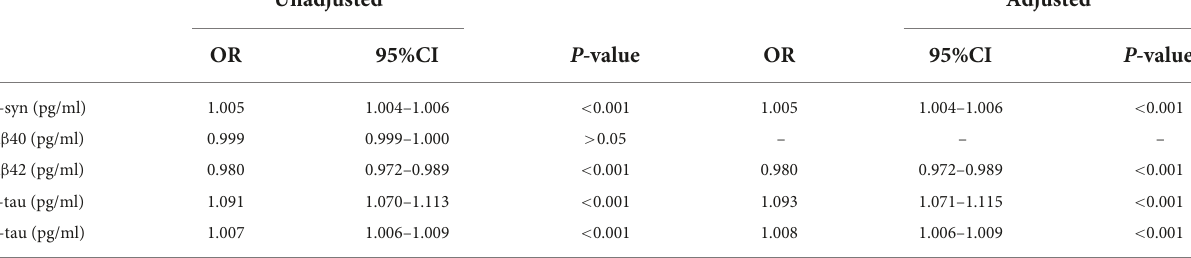
TABLE 2 Logistic regression analysis.